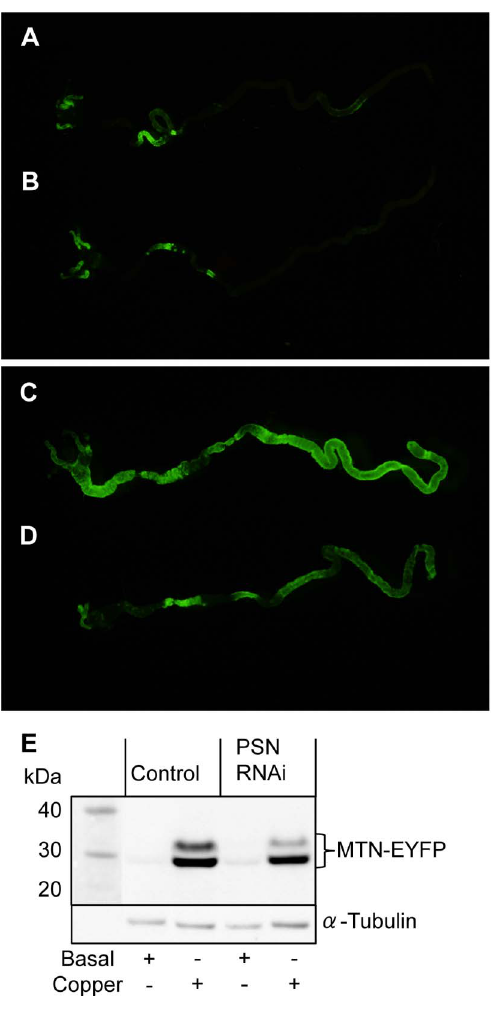
Figure 4. MTN-EYFP expression in Drosophila . Drosophila express- ing a copper-inducible MTN-EYFP construct (green) were reared until third instar on basal media (A, B) and media supplemented with 0.5 mM copper (C, D). Gut tissue incorporating the gastric caecum and anterior midgut (left) to the posterior midgut (right) was dissected from control (A, C) and midgut PSN knockdown (B, D) larvae. MTN-EYFP expression was greater in the gut of control larvae reared on copper-supplemented media(C) than those on basal media (A), indicative of increased copper levels. Under basal condition, MTN-EYFP expression in the gut of PSN knockdown (B) and control (A) larvae was comparable. When reared on copper-supplemented media MTN-EYFP levels were lower in the gut of PSN knockdown larvae (D) than control (C), consistent with reduced copper levels. Western immunoblotting with a GFP antibody was used to confirm MTN-EYFP levels in pooled samples of five larvae reared on basal media and media supplemented with 0.5 mM copper (E). a - Tubulin was used as a loading control. When reared on copper- supplemented media MTN-EYFP levels were lower in the gut of PSN knockdown larvae than